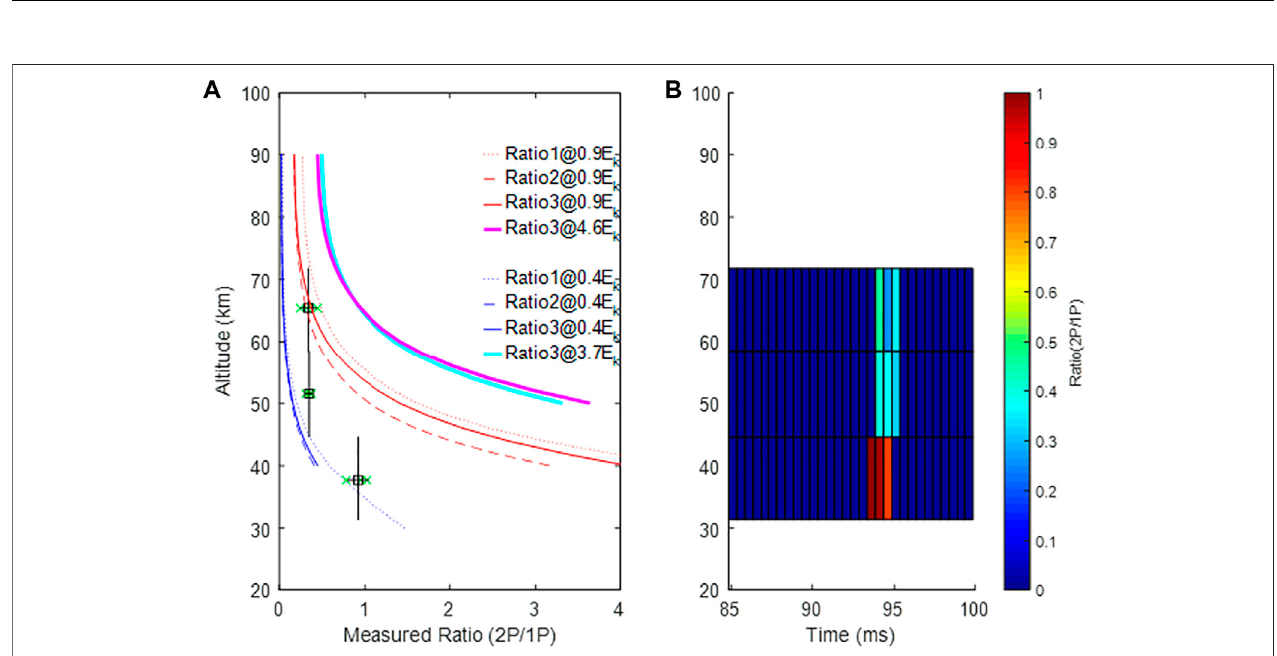
60 km, surprisingly, AP-measured ratios fell below the predicted ratio 1 E k . We conjectured that the lower emission ratios are contributed from those non-streamer regions (upper propagating streamer, sprite beads, and glow) by Stenbaek-Nielsen et al. (2020). In addition, the AP-measured ratios have a lower bound of predicted emission ratios associated with 0.4 E k .